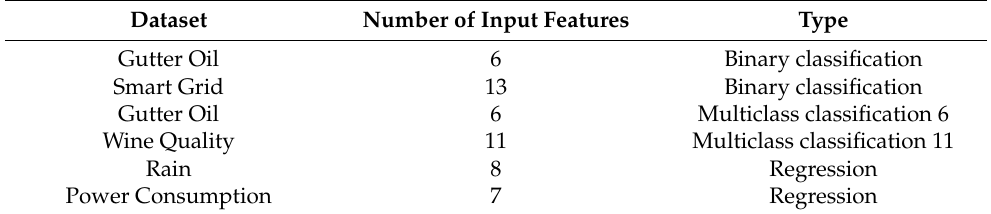
Table 6. Dataset specifications.